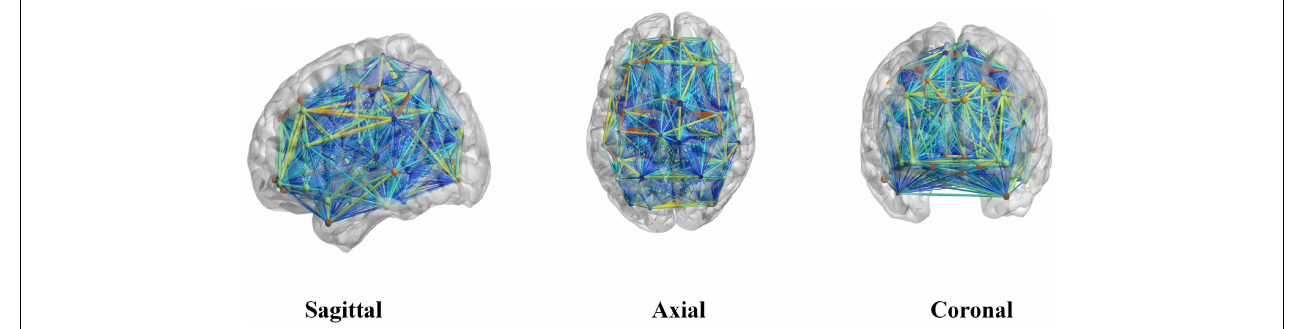
FIGURE 1 | A brain network connectivity map generated using the BrainNet Viewer